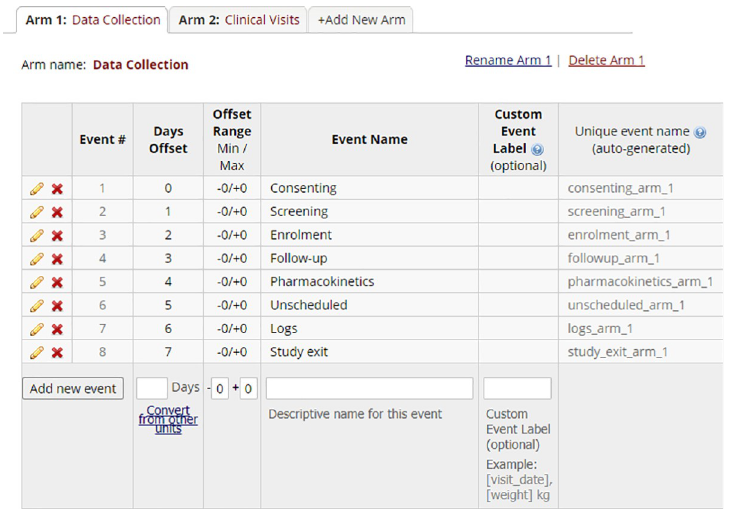
Fig 2. Encapsulation of data collection arm & clinical visits